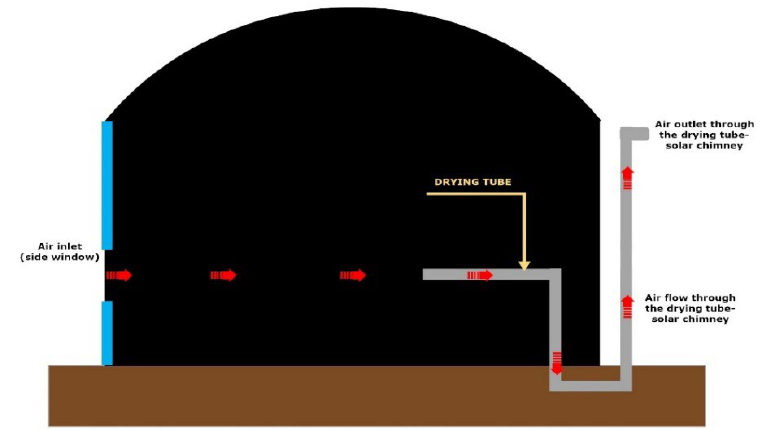
Figure 2. Drying system operation rationale.